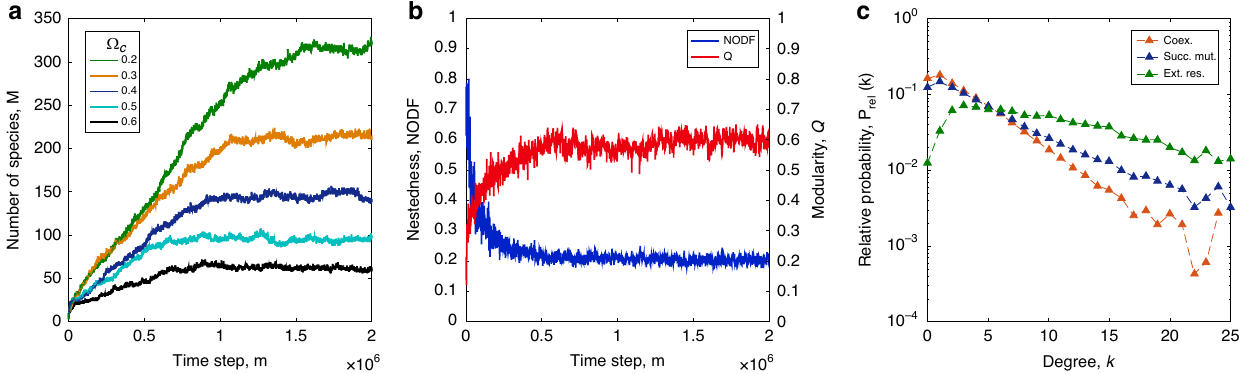
Fig. 5 Invasions to mutualistic networks. a Starting from a small core of species ( M = 4), the total number of species M increases and eventually saturates at a level that decreases with the competition intensity Ω c . b As M increases and stabilizes, the nestedness NODF decreases and modularity Q increases shown here explicitly for Ω c = 0.4. c Starting from a large mutualistic network ( M = 112) the relative probabilities for the survival of a mutant, the extinction of an invaded resident, and the coexistence of resident and mutant, as a function of resident degree k , measured Δ m = 500 time steps after the